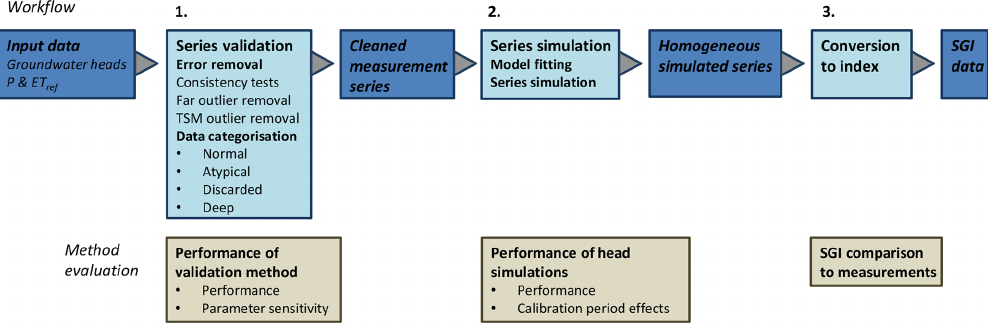
Figure 2. Method